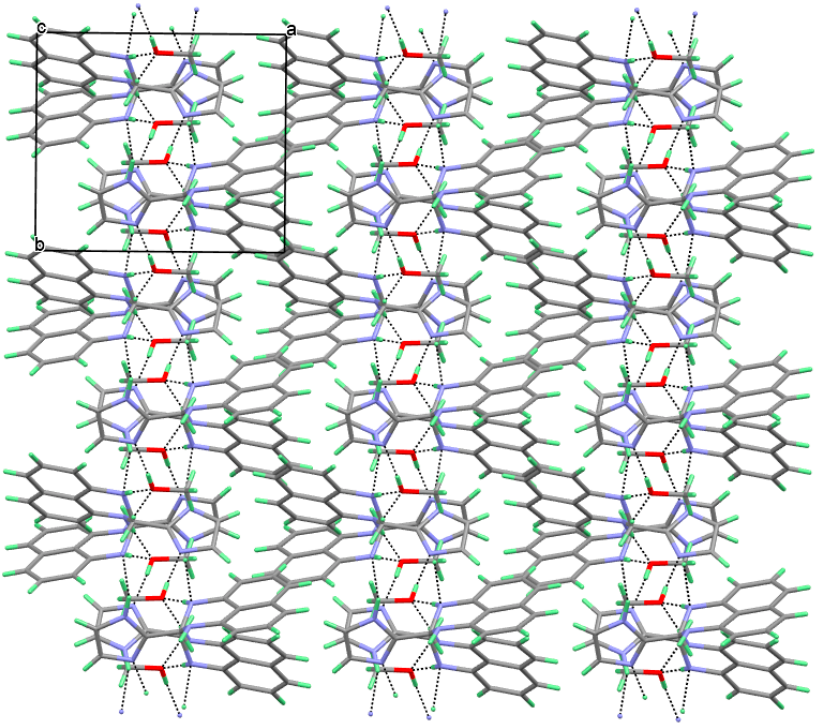
Figure 4. Observed hydrogen bonding interactions stabilizing the crystal packing in the title compound.